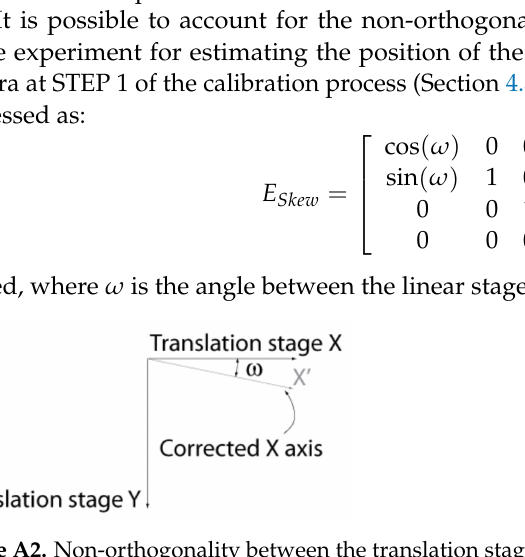
Figure A2. Non-orthogonality between the translation stages expressed by parameter ω